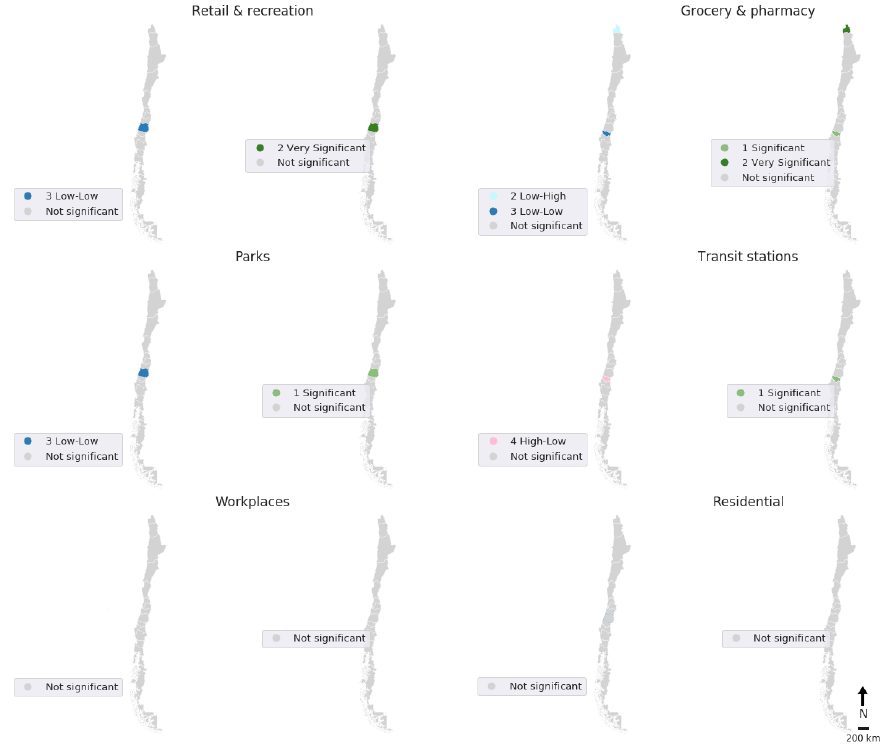
Figure 24. Cluster maps and LISA significance maps for Google categories from 1 June to 27 October 2020: Chile. Covid-19 Community Mobility Reports,